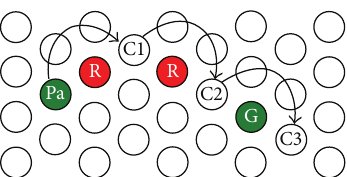
Figure 8: Single-piece-jump. Pa can jump to C1, C2, and